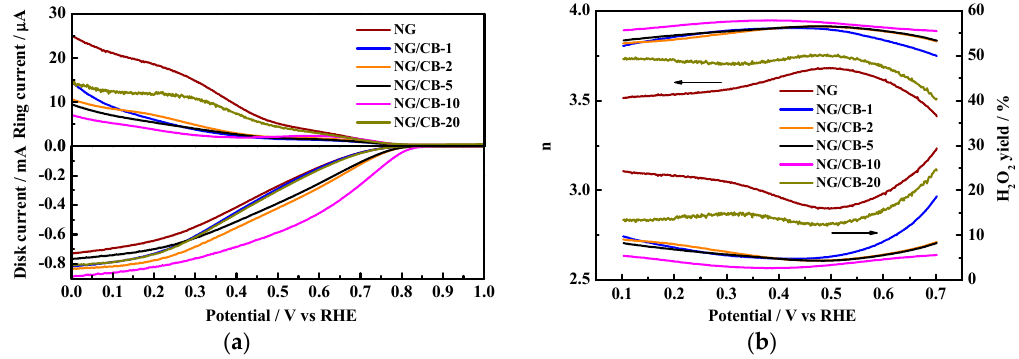
Figure 2. The current-potential profiles of RRDE tests in O 2 -saturated 0.1 M PBS at 1600 rpm ( a ) and corresponding H 2 O 2 yield and electron transfer number ( b ) of NG/CB-x electrocatalysts. The electrocatalyst loading on RRDE was 100 μ g cm − 2 .